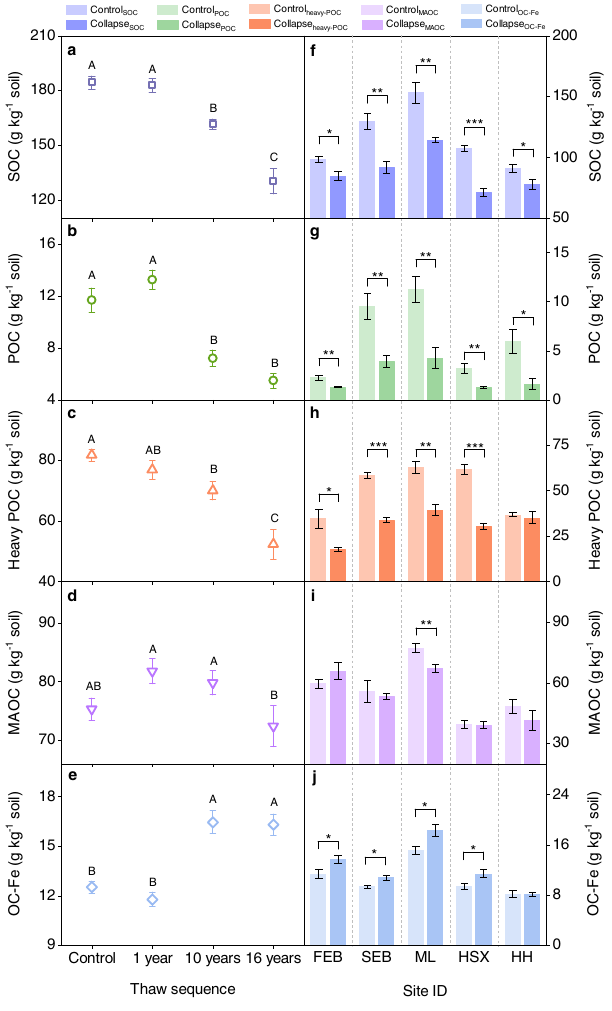
Fig. 2 | Changes of SOC and its fractions induced by permafrost collapse. a – e ChangesincontentsofSOC( a ),POC( b ),heavyPOC( c ),MAOC( d ),andOC-Fe( e ) along a permafrost thaw sequence. f – j Comparisons of SOC ( f ), POC ( g ), heavy POC ( h ),MOAC( i ),andOC-Fe( j )betweencollapsed(darkcolour)andcontrol(lightcolor) plots at each of the fi ve regional thermokarst-impacted sites: FEB, SEB, ML, HSX, and HH. SOC, soil organic carbon; POC, particulate organic carbon (density<1.6gcm − 3 ); Heavy POC, heavy particulate organic carbon (density>1.6gcm − 3 and size>53 μ m); MAOC, mineral-associated organic carbon (density>1.6gcm − 3 and size<53 μ m);OC- Fe,iron-boundorganiccarbon;FEB,the fi rstsiteatEbo;SEB,thesecondsitelocatedat Ebo; ML, HSX, and HH indicate the sites at Mole, Huashixia, and Huanghe, respec- tively.Errorbarsrepresentstandarderrors.Differentcapitallettersindicatesigni fi cant differencesforthevariableswithinplotsalongthethawsequence(LSDtest, P <0.05). Dashed lines distinguish different thermokarst-impacted sites, denoting that the parametersarecomparedbetweencollapsedandcontrolplotsineachsiteratherthan across various study sites. SOC data along the thaw sequence were reanalyzed from ref. 13. * P <0.05, ** P <0.01, and *** P <0.001.